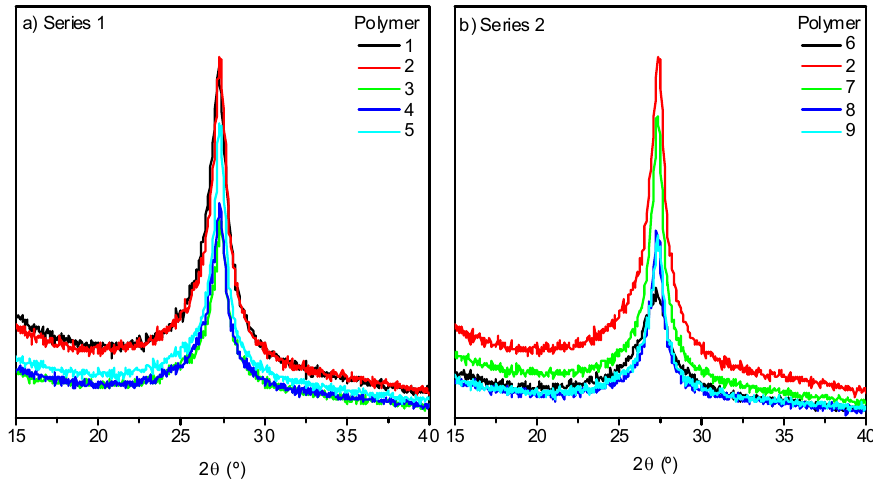
Figure 5. XRD patterns of representative samples from both series, Series 1 ( a ) and Series 2 ( b ), synthesized by a MW method.